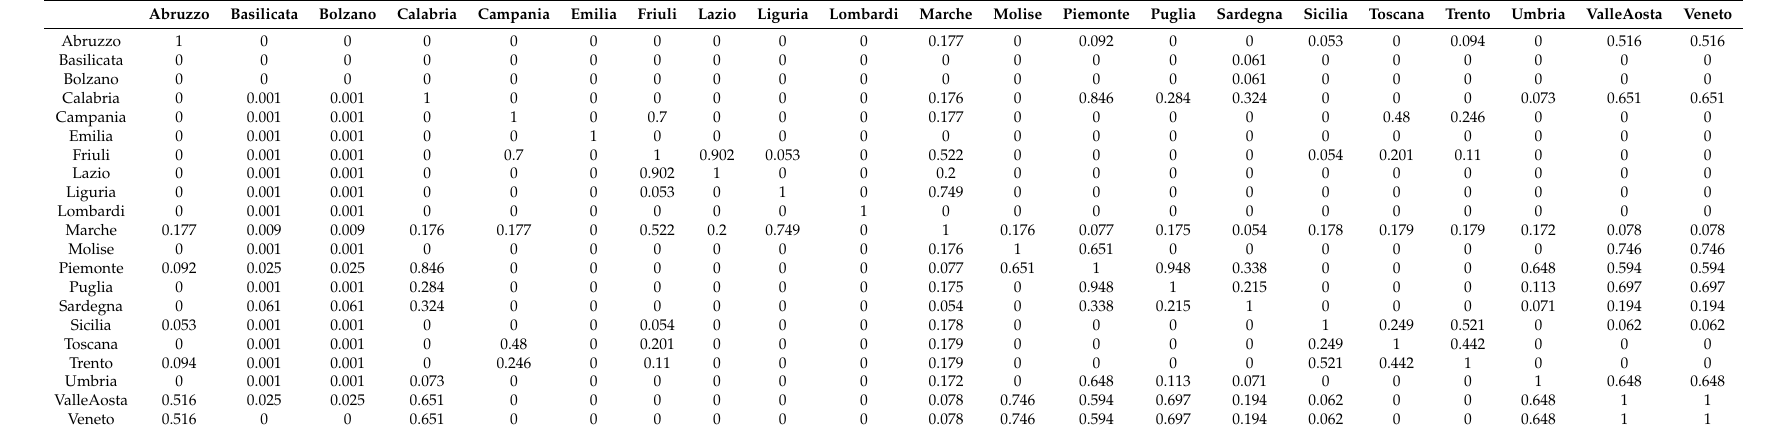
Table A41. Similarity values of Discharged/Healed network in the fourth week.